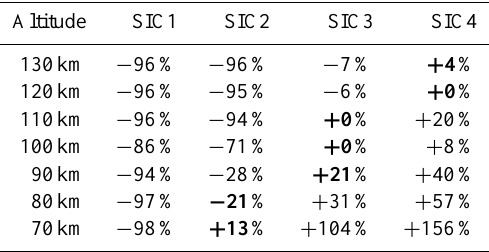
Table 3. Median relative differences in electron concentration be- tween the SIC model runs and EISCAT observations between 28 October and 2 November 2003 (Case 1). The values in bold face indicate the smallest difference at the corresponding altitude.